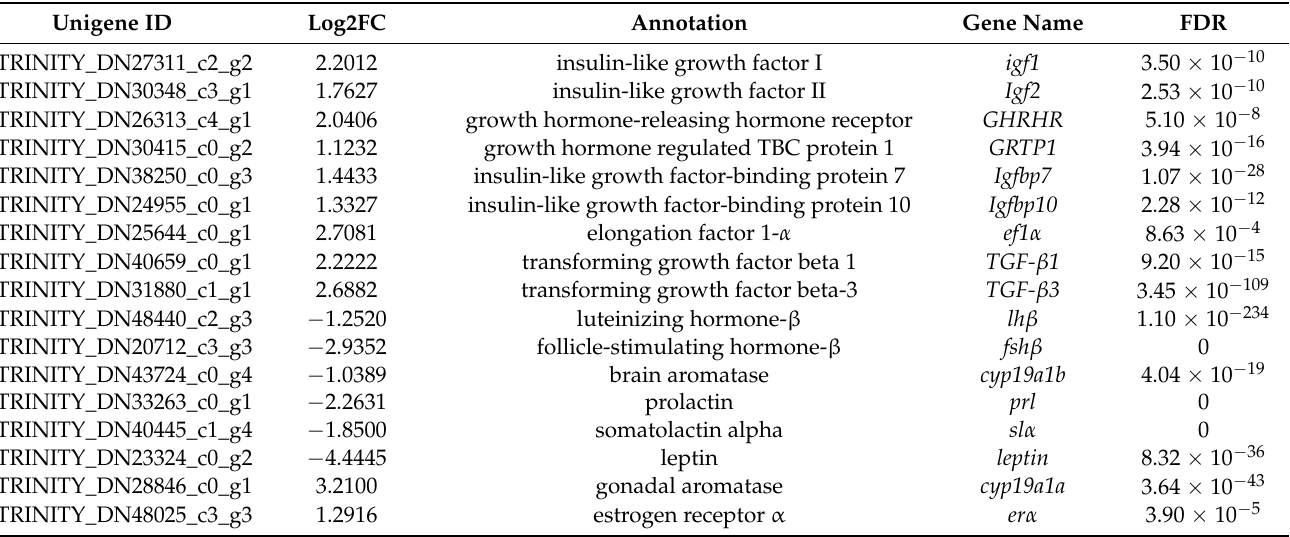
Table 1. Some key DEGs associated with growth and ovarian maturity identified by the pairwise- comparisons of diploid and tetraploid M. anguillicaudatus